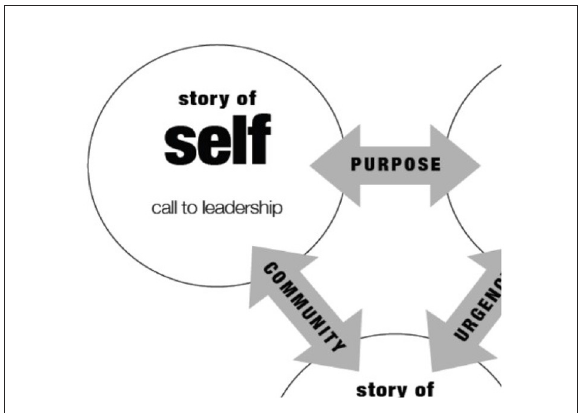
FIGURE2 The three elements of Public Narrative. Source: Marshall Ganz. 2009. What Is Public Narrative: Self, us & now. (Public Narrative Worksheet). Working